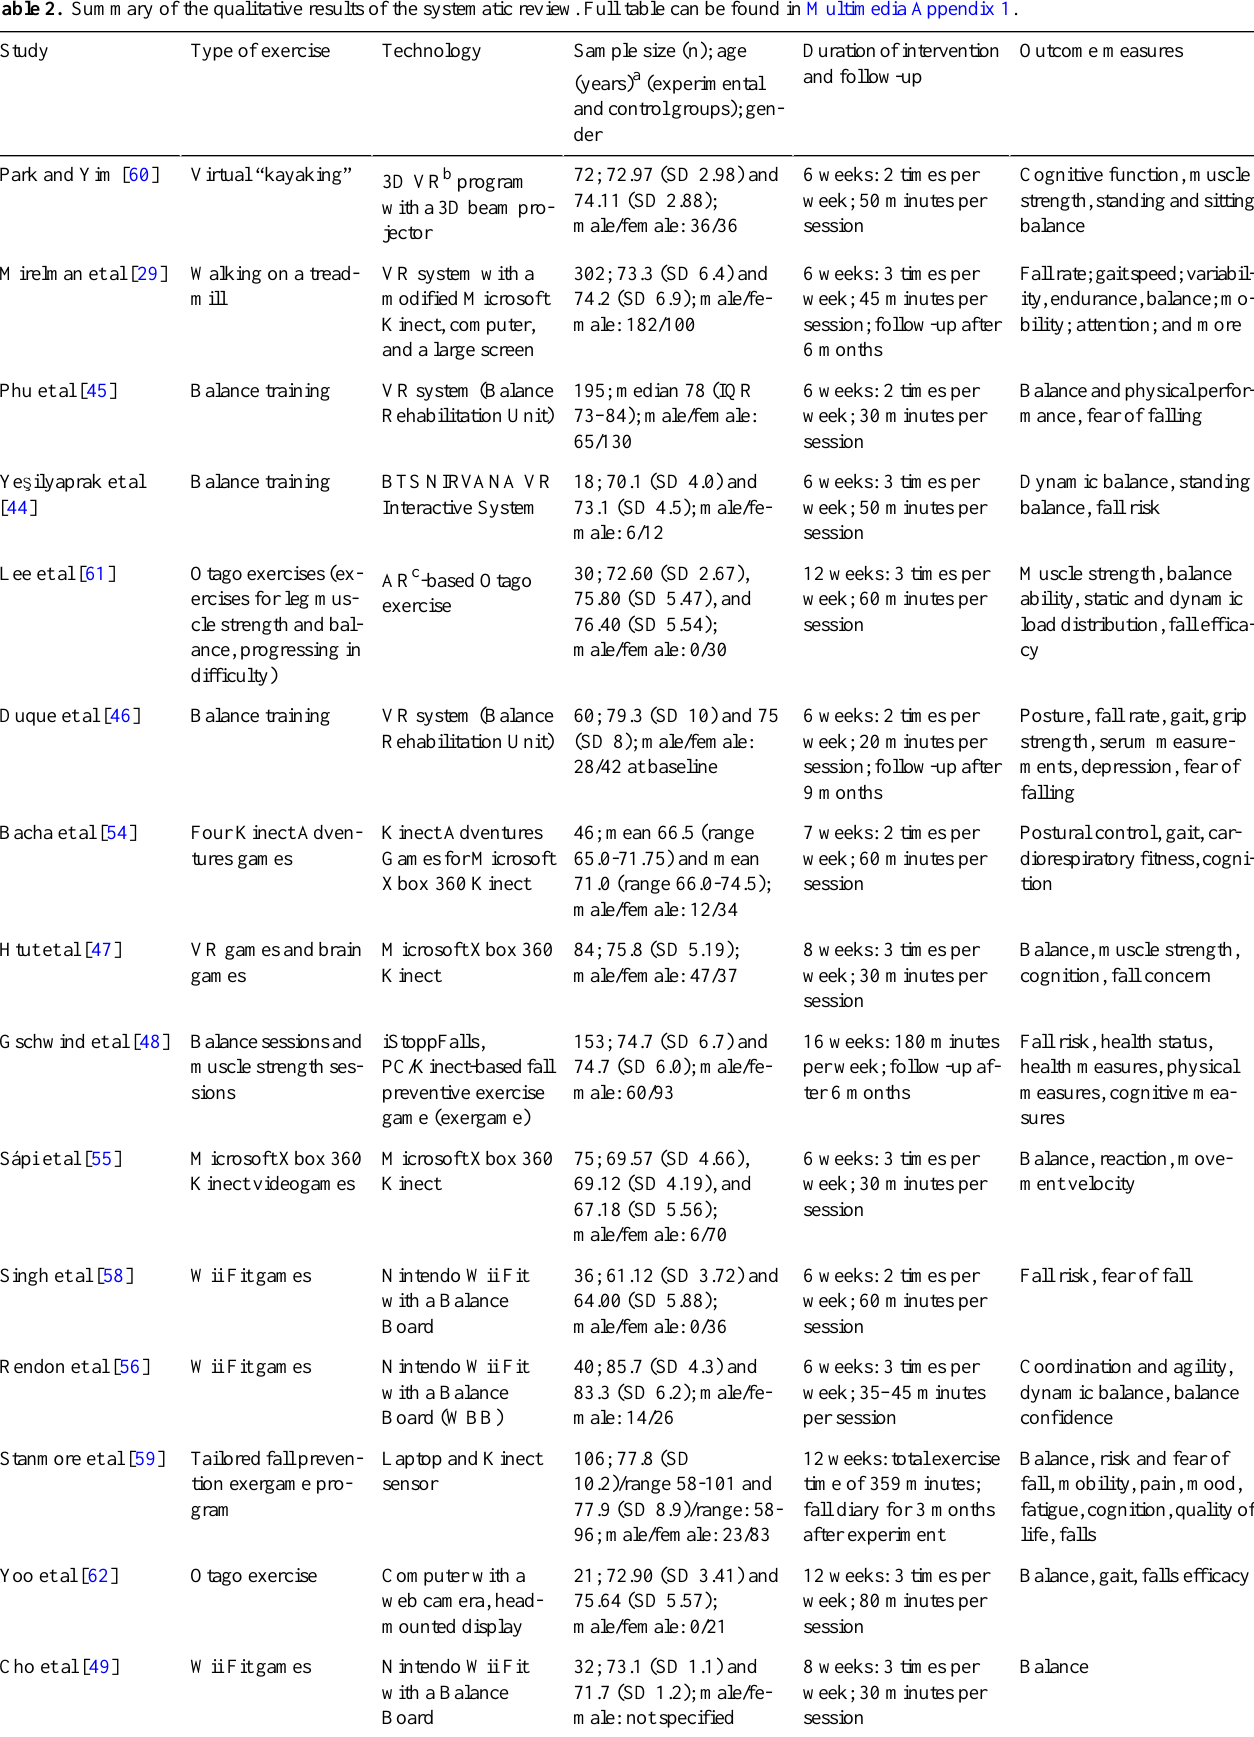
Table 2. Summary of the qualitative results of the systematic review. Full table can be found in Multimedia Appendix 1.